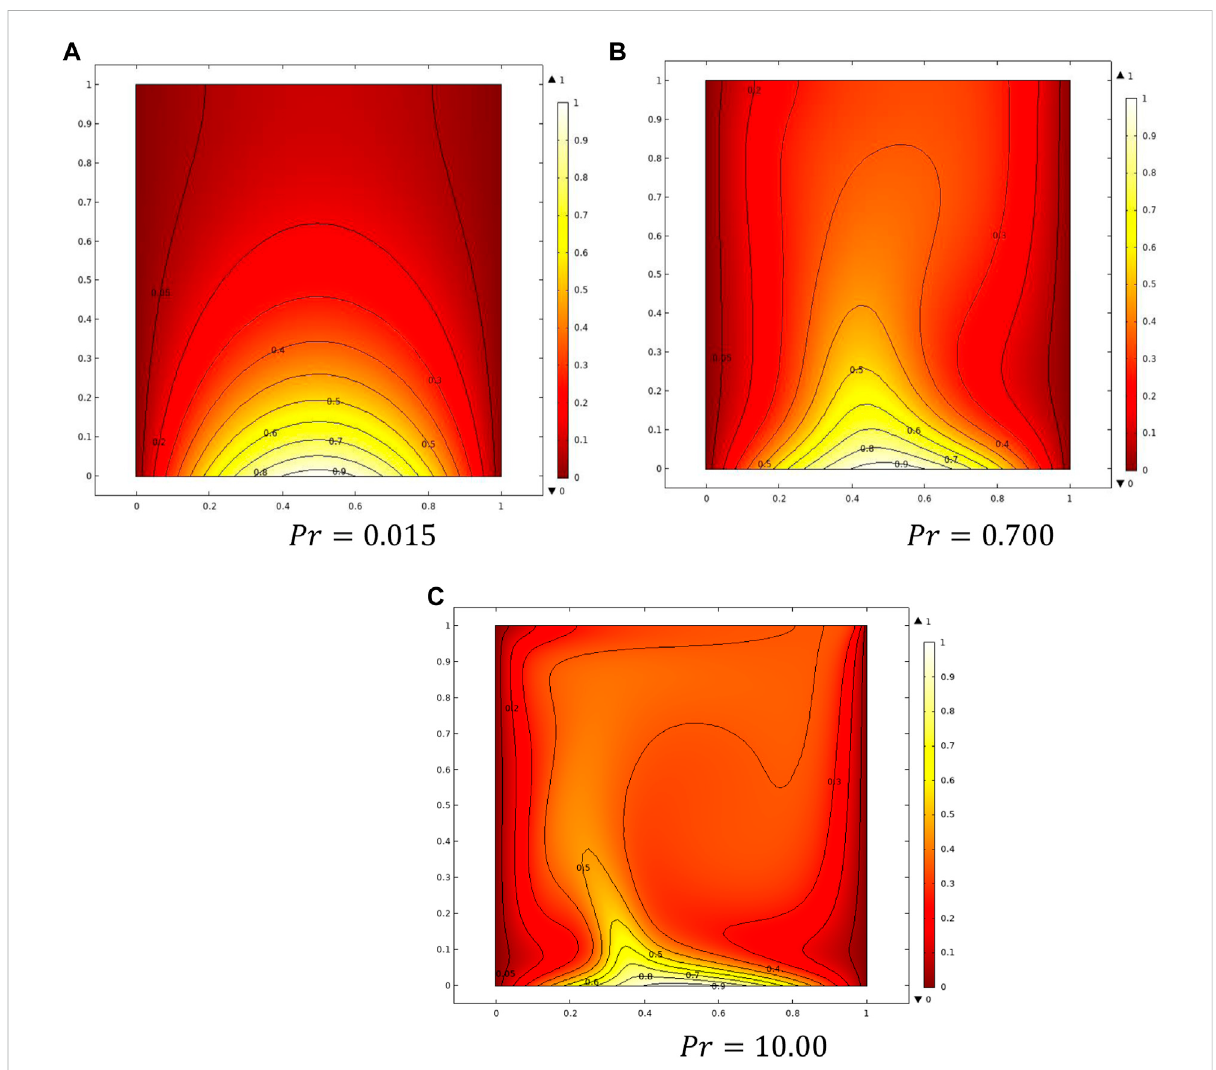
FIGURE 16 In fl uence of Pr on temperature distribution for the non-uniform heating case: (A) Pr (cid:1) 0 . 015, (B) Pr (cid:1) 0 . 700, and (C) Pr (cid:1) 10 . 00.